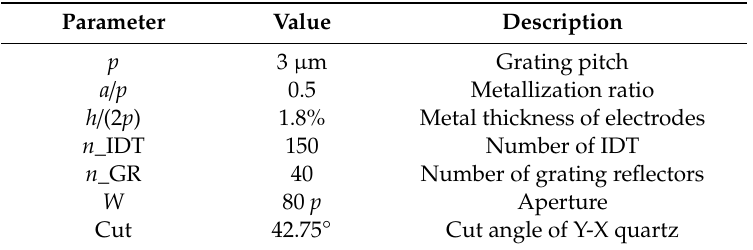
Table 1. Detailed information on the above experimental sample.